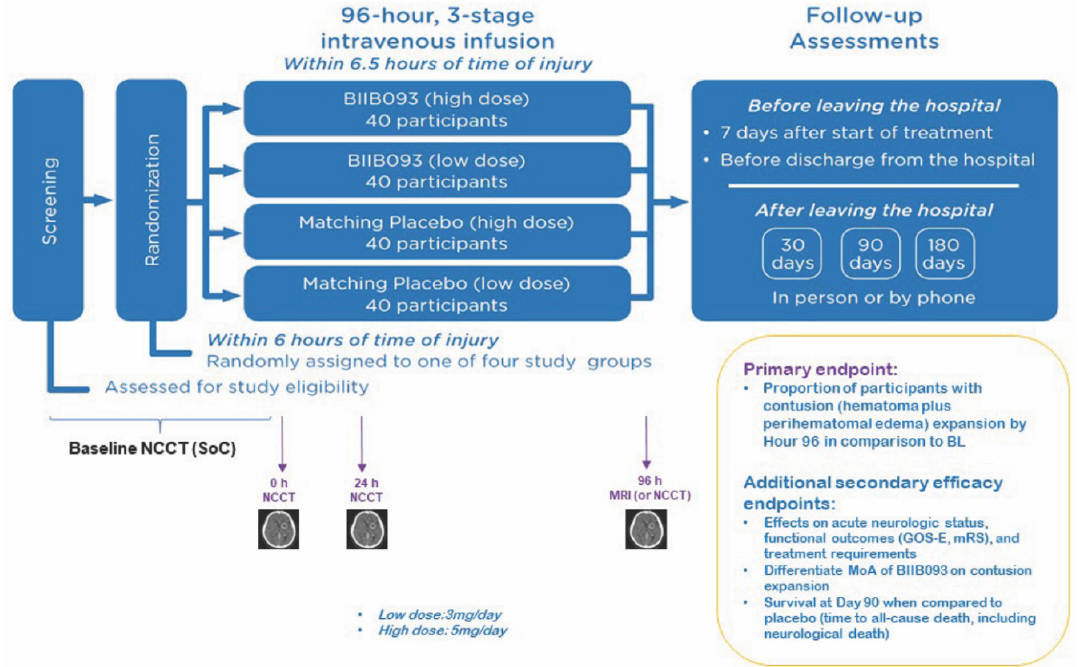
Figure 6. ASTRAL clinical trial design schematic. Diagram outlining the clinical design trial for ASTRAL, a Phase-2 multicenter, international, double-blind, multidose, placebo-controlled, randomized clinical trial evaluating the safety and efficacy of BIIB093 in supratentorial contusion-TBI (NCT03954041, Antagonizing S UR1- T RPM4 to reduce the progression of intracerebral hematoma and edema surrounding lesions). Distribution of participants to high vs. low dose BIIB093 vs. matching placebo is presented; patients are randomized within 6 h of time of injury. The primary end point is documented by 96 h MRI or non-contrast CT and related to proportion of participants with contusion expansion vs. baseline. Additional secondary efficacy endpoints will also be obtained as illustrated. Time-points for key follow up assessments are also shown including 7 days after treatment, prior to hospital discharge, 30-day, 90-day, or 180-day